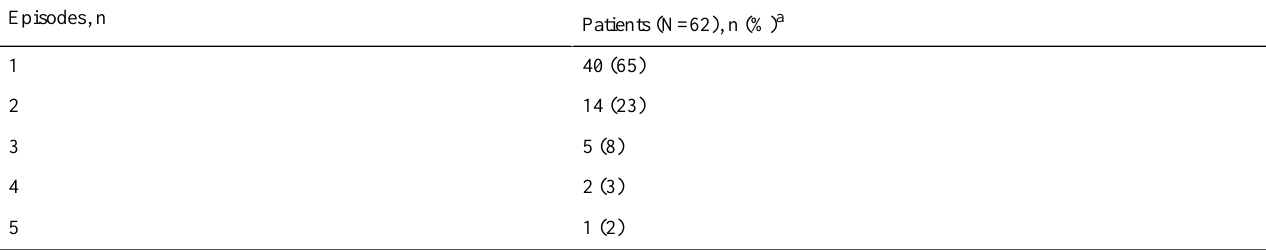
Table 2. Frequency distribution of patients per number of annotated chronic pain